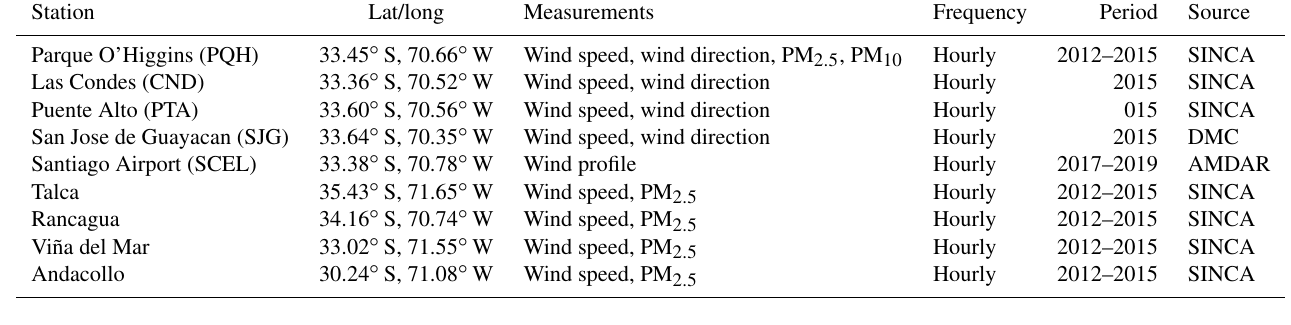
Table 2. Weather and air quality stations used in this work and their available measurements and periods. Station